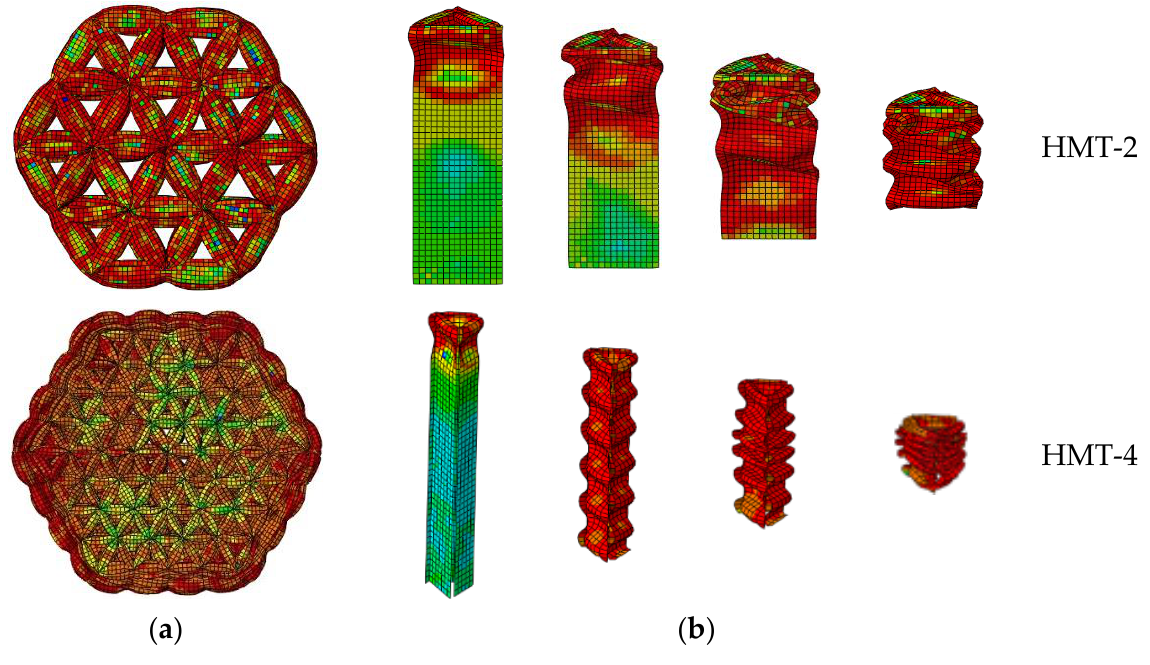
Figure 14. FEM progressive crushing of compressed HMTs: ( a ) top view and ( b ) folding of a typical unit cell column.